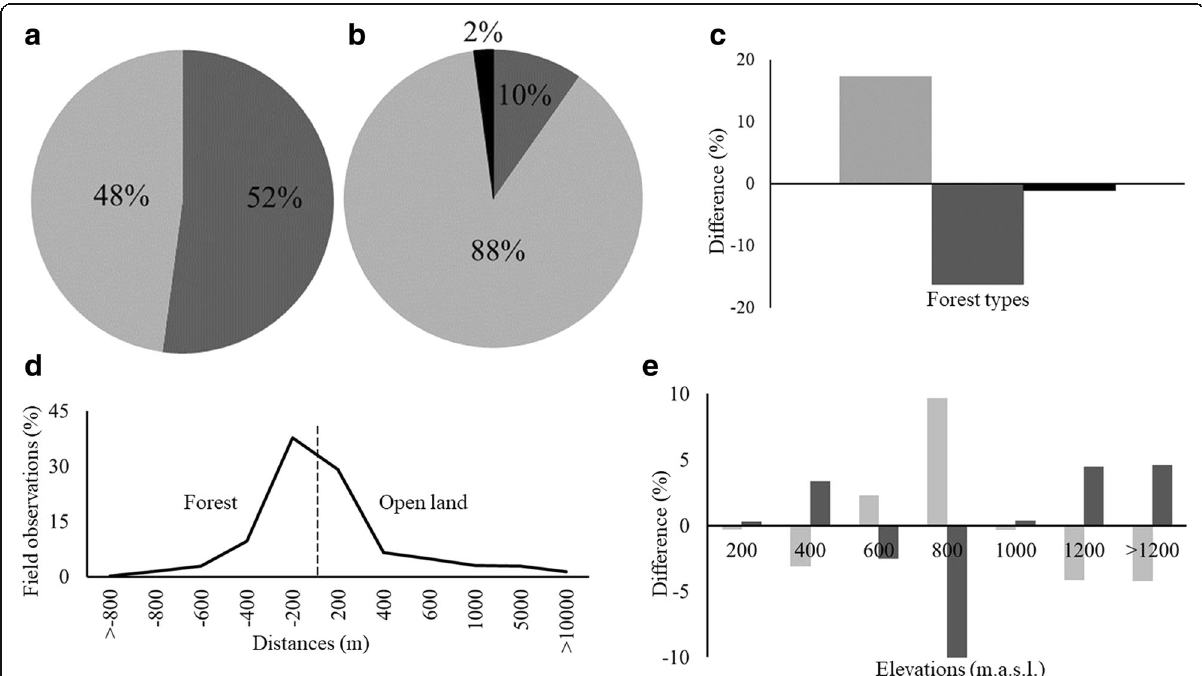
Fig. 2 Characteristics of the huemul field observation data base classified by: a ecosystem types ( pale gray =shrublands and grasslands, gray =forests); b forest types ( pale gray = N. pumilio , gray = N. antarctica , black =mixed evergreen); c difference between percentage of field observations in each forest type and the percentage of each forest type area in Santa Cruz province ( light gray = N. pumilio , gray = N. antarctica , black =mixed evergreen); d field observation distances (m) from the forest edge expressed as the percentage of the total data; and e difference between percentage of total field observations at each altitude (m.a.s.l.) and the percentage of field observations in each ecosystem type ( light gray =forests, dark gray =open lands) at each elevation